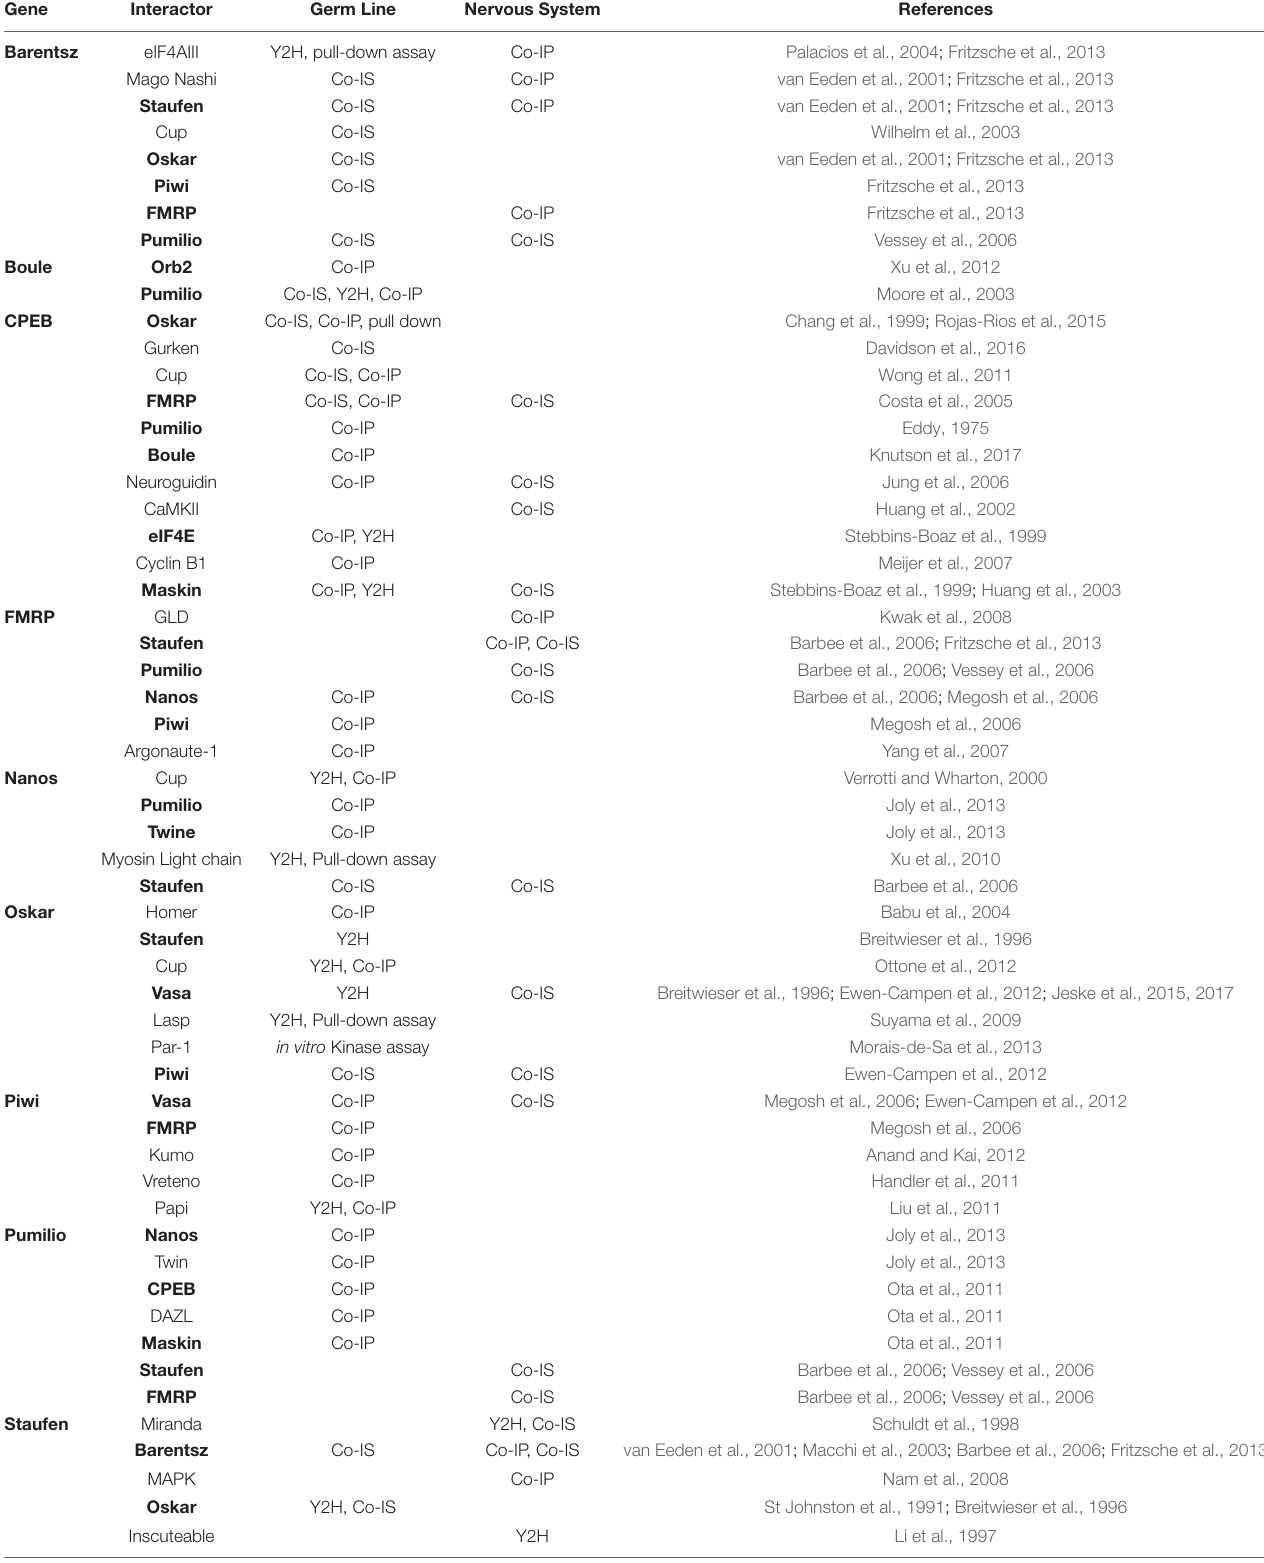
TABLE 2 | Summary of selected gene products and their reported physical interactors in the germ line and in nervous system tissues, listed here in alphabetical order. Gene Interactor Germ Line Nervous